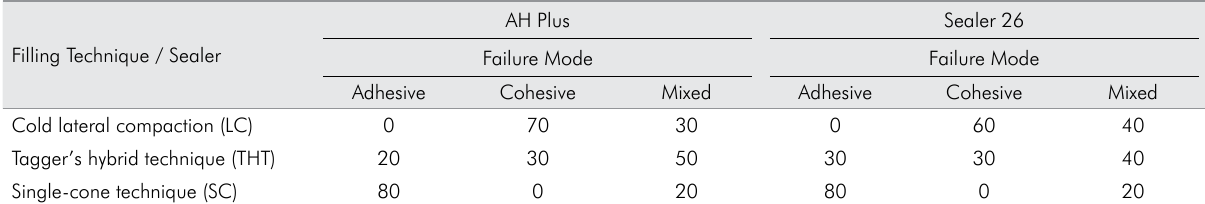
Table 2. Distribution of failure modes (%) after the push-out test for each type of root canal filling technique/sealer. Filling Technique /